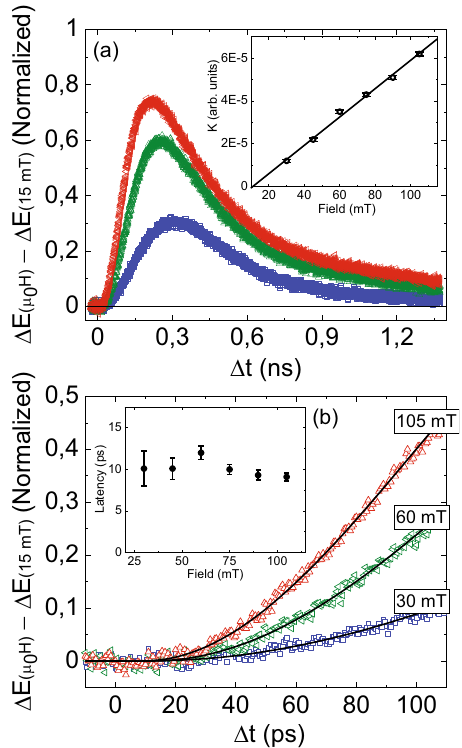
Fig. 5 The double-pump THz emission due to emerging ferromagnetism in antiferromagnetic FeRh/Pt, Δ E( μ 0 H) – Δ E(15 mT) ( μ 0 H = 30, 60, and 105 mT) at 300K. a shows the sub-nanosecond dynamics. The inset shows the extracted K coef fi cient as a function of the applied fi eld. The linear line is a guide to the eye. b shows the picosecond dynamics. The solid lines are the fi ts to Eq. (1). The inset shows the extracted latency as a function of the applied fi